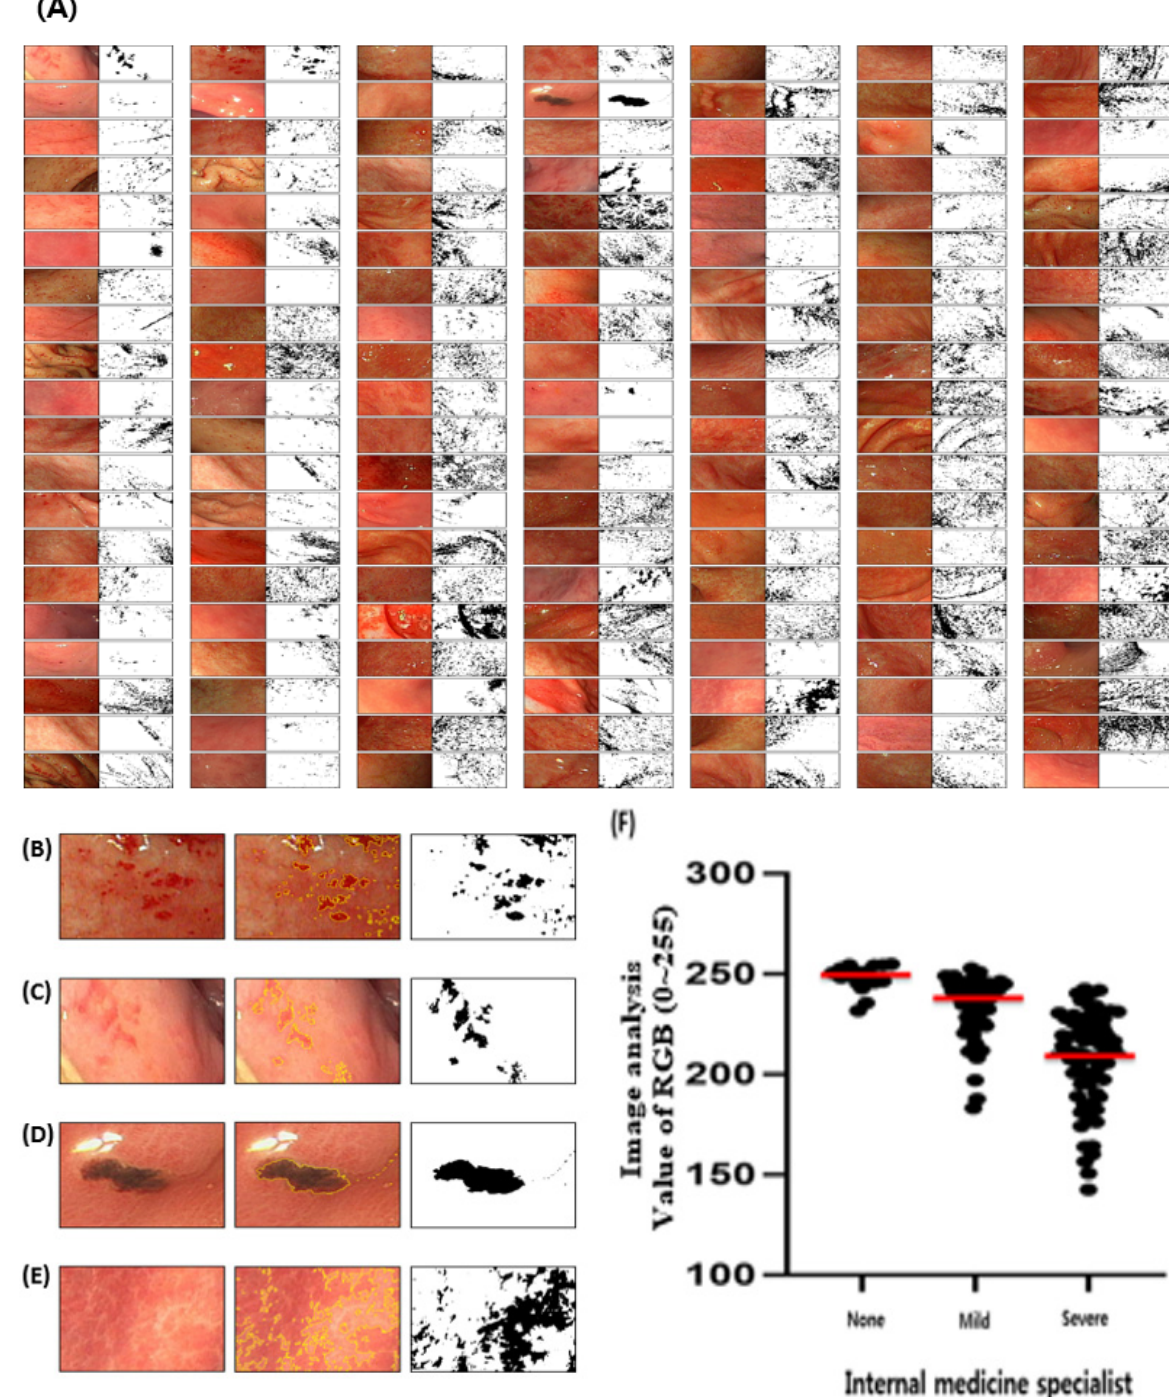
Figure 5. Measurement of gastric ulcers from clinical specimens/images. A 140-image dataset of gastric ulcers was analyzed by the ImageJ software, and a reader study was performed using the 140 images ( A ). Several types of gastric symptoms were observed and classified into severe erythematous area with red spot area ( B ), slight erythema ( C ), H. pylori infection ( D ), and defense against ulcer with gastric juice ( E ) as the white area. ( F ) Gastric ulcer measurements in clinical specimens were analyzed with ImageJ by adjusting RGB values between 0 and 225.